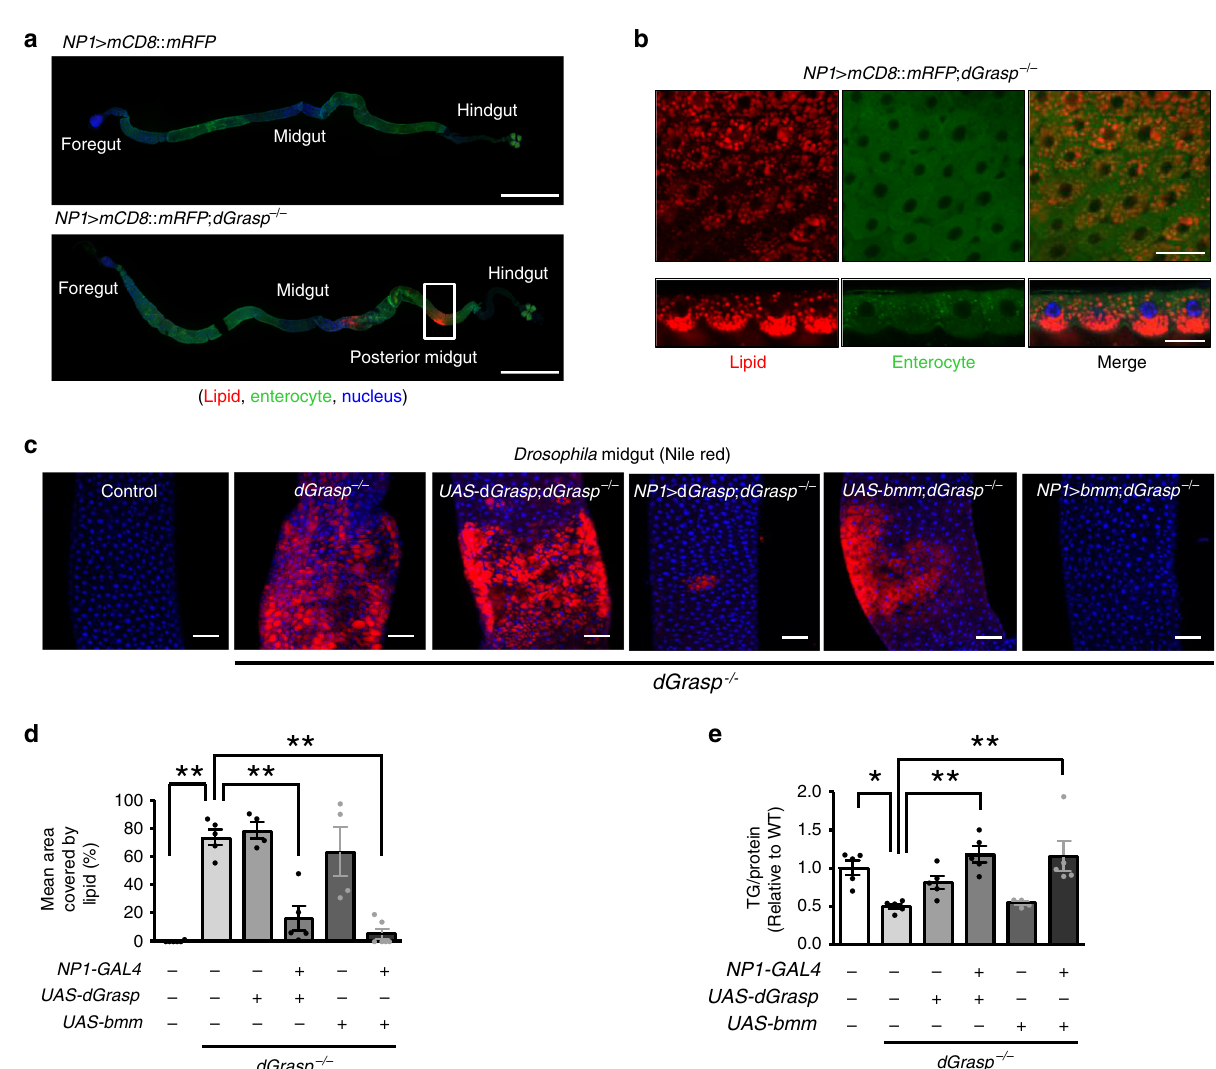
Fig. 10 The role of dGRASP in intestinal lipid absorption and whole-body TG storage in adult fl ies. The dGrasp -null mutant allele ( dGrasp − / − ), also known as dGrasp 302 , harbors a deletion of the whole dGrasp coding region. a , b Lipid accumulation in enterocytes of posterior midguts of dGrasp − / − fl ies. Enterocytes of NP1>mCD8::RFP fl y guts were stained with antibodies against DsRed (green) and nuclei were counterstained with TO-PRO-3 (blue). Lipids were visualized by staining with BODIPY solution (red). For consistency, pseudocolors were used. Confocal microscopic images of whole guts from control ( NP1>mCD8::RFP ) and dGrasp -mutant fl ies ( NP1>mCD8::RFP;dGrasp − / − ) are shown in ( a ). Scale bars: 1 mm. Boxed area indicates the posterior midgut where lipids accumulated. Image sections of the boxed area taken from the top (upper, scale bar: 25 μ m) and lateral (bottom, scale bar: 10 μ m) orientations are shown in ( b ). c , d Confocal microscopic images of lipid accumulation in the fl y guts of the indicated genotypes. The fl y genes dGrasp and bmm are homologs of mammalian GRASP and ATGL , respectively. Each gene was expressed in the enterocytes of dGrasp − / − fl ies under the control of NP1-GAL4. Lipids were visualized by staining with Nile Red (red) and nuclei were counterstained with TO-PRO-3 (blue). Representative images of the posterior midguts are shown in ( c ), and quantitative analyses of intestinal lipid accumulation in the indicated genotypes of the fl ies are presented in ( d ), n = 4 – 6. Scale bars: 50 μ m. e Quantitative analyses of relative whole-body TG contents in the indicated genotypes of the fl ies ( n = 5). UAS, upstream activation sequence. Data are shown as mean ± SEM. * p < 0.05, ** p < 0.01. All p values were calculated by ANOVA followed by Tukey ’ s multiple comparison tests. Source data are provided as a Source Data fi